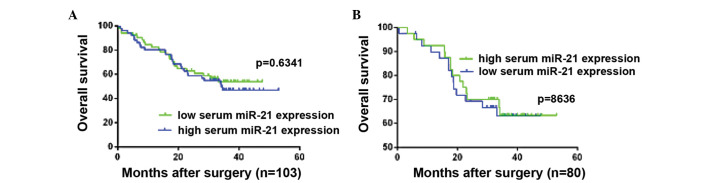
Kaplan-Meier overall survival curves for (A) all 103 gastric cancer (GC) patients, and (B) 80 GC patients who underwent curative surgery, according to the level of microRNA-21 (miR-21) expression. Log-rank tests showed that there were no significant differences between the low miR-21 expression and the high miR-21 expression groups (P=0.634 and P=0.863, respectively).